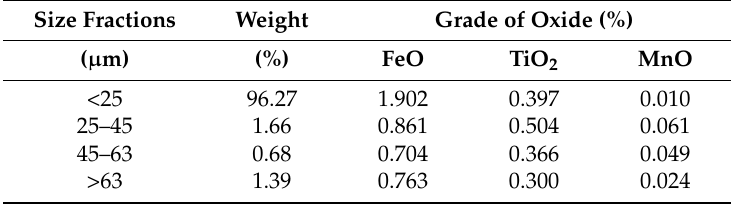
Table 4. Particle size and grades of FeO, TiO 2 , and MnO in four size